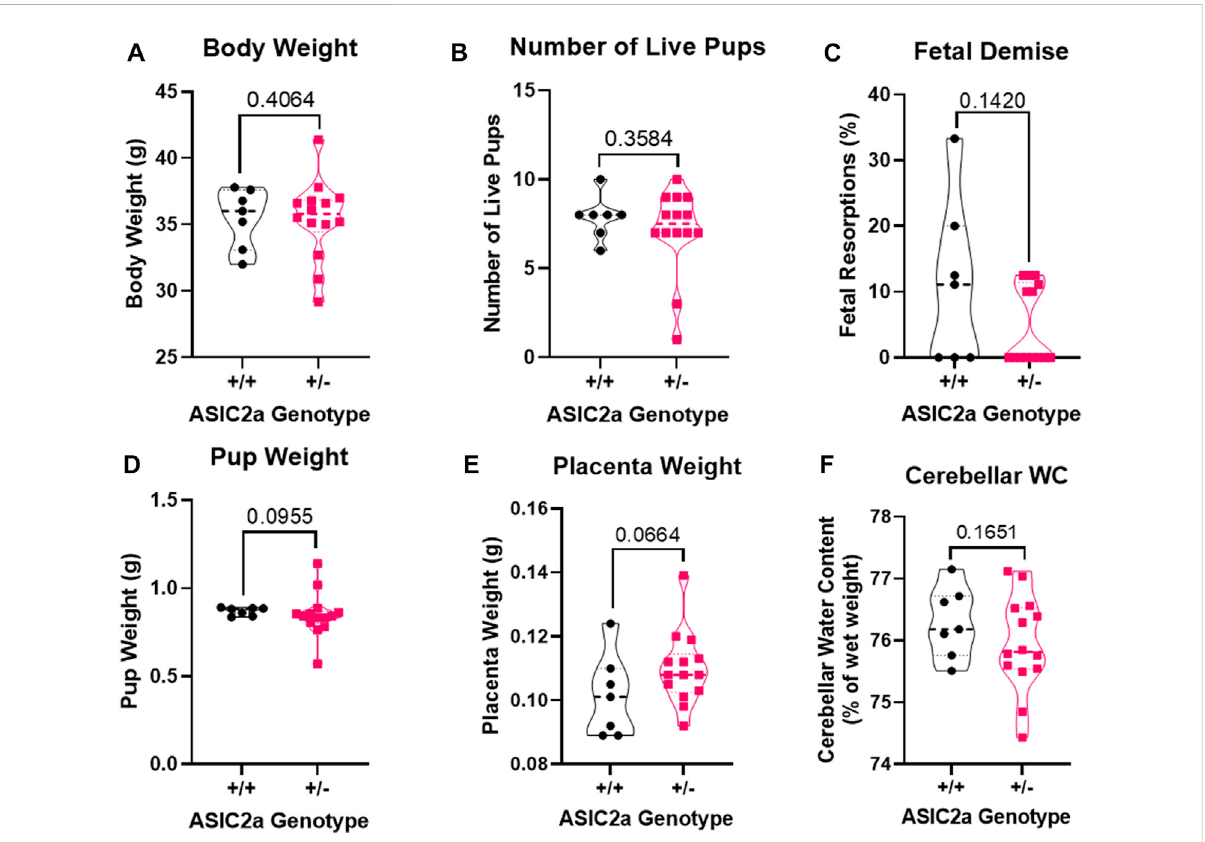
FIGURE 1 General pregnancy characteristics of mice at gestational day 18.5 of pregnancy. There was no difference in (A) body mass, (B) number of live pups in utero , (C) fetal demise, (D) average pup weight, (E) average placental weight, or (F) cerebellum water content between ASIC2a +/+ and +/- pregnant mice. N = 7 or 14 per genotype. Individual data points are displayed. Thick dashed line is the median and the thin dashed lines are the quartiles. Signi fi cance was calculated using Mann-Whitney U